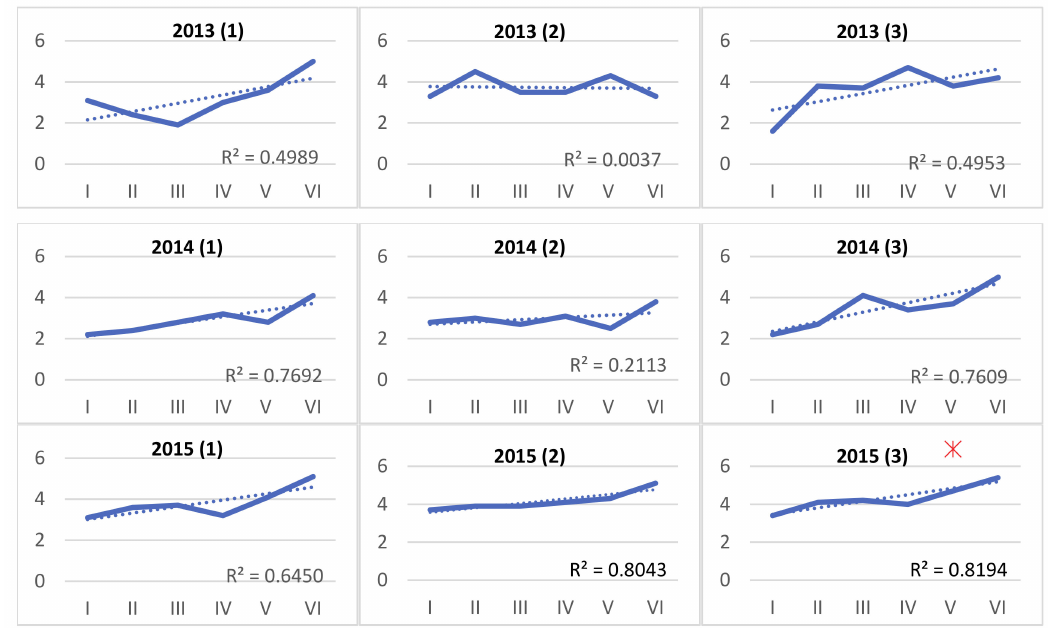
Figure 4. Trend over time of OE yield in Origanum heracleoticum in 3 years (2013 to 2015) and 3 locations (1 to 3). In each graph, regression lines (dotted lines) and corresponding R 2 values are indicated. A red asterisk (*) marks an outlier.